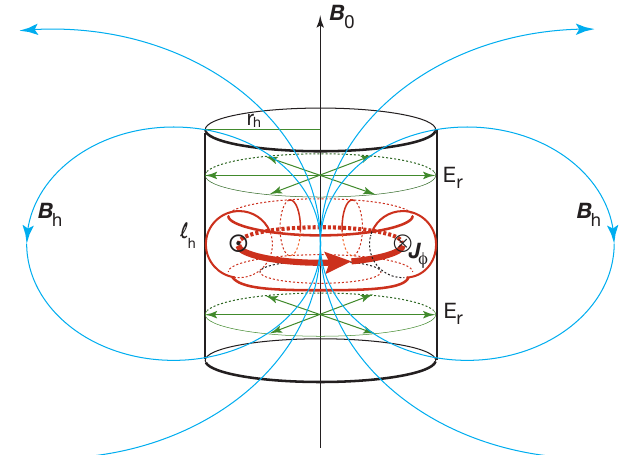
Fig. 2. The cylindrical model of the electron hole used in the cal- culation. The hole has length ‘ h along the ambient magnetic field B 0 and radius r h . Its positive charge generates the radial electric field E r , shown here in green. Electron perform an E × B drift in the crossed fields E r and B 0 , which is in − φ direction. This drift corresponds to a current J direction in + φ . This solenoidal current, shown in red, generates the hole magnetic field, which outside the hole appears as the dipolar magnetic field B h , of which here only one planar section is shown in